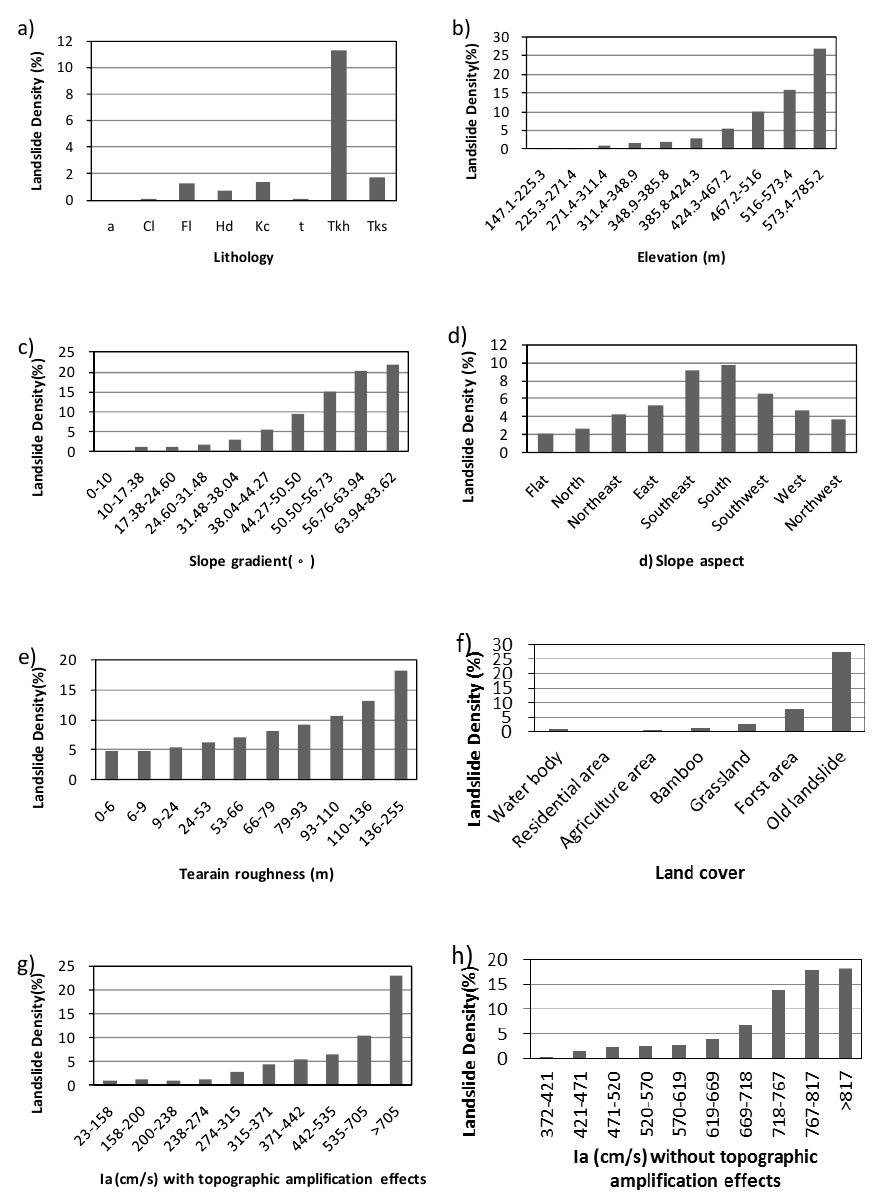
Fig. 7. Landslide density for each class of a variable: (a) lithology, (b) elevation, (c) slope gradient, (d) slope aspect, (e) terrain roughness, (f) land cover, (g) I a with amplification effects, and (h) I a without amplification effects. the Chelungpu fault. The 99 Peaks region is just above the Chelungpu fault. The section of the Chelungpu fault under the 99 Peaks region has S strike and dips of N 6 ◦ W and 28 ◦ E, respectively. These values of the strike and dip were used to set up the incidence angle of incident shear waves in the wave propagation